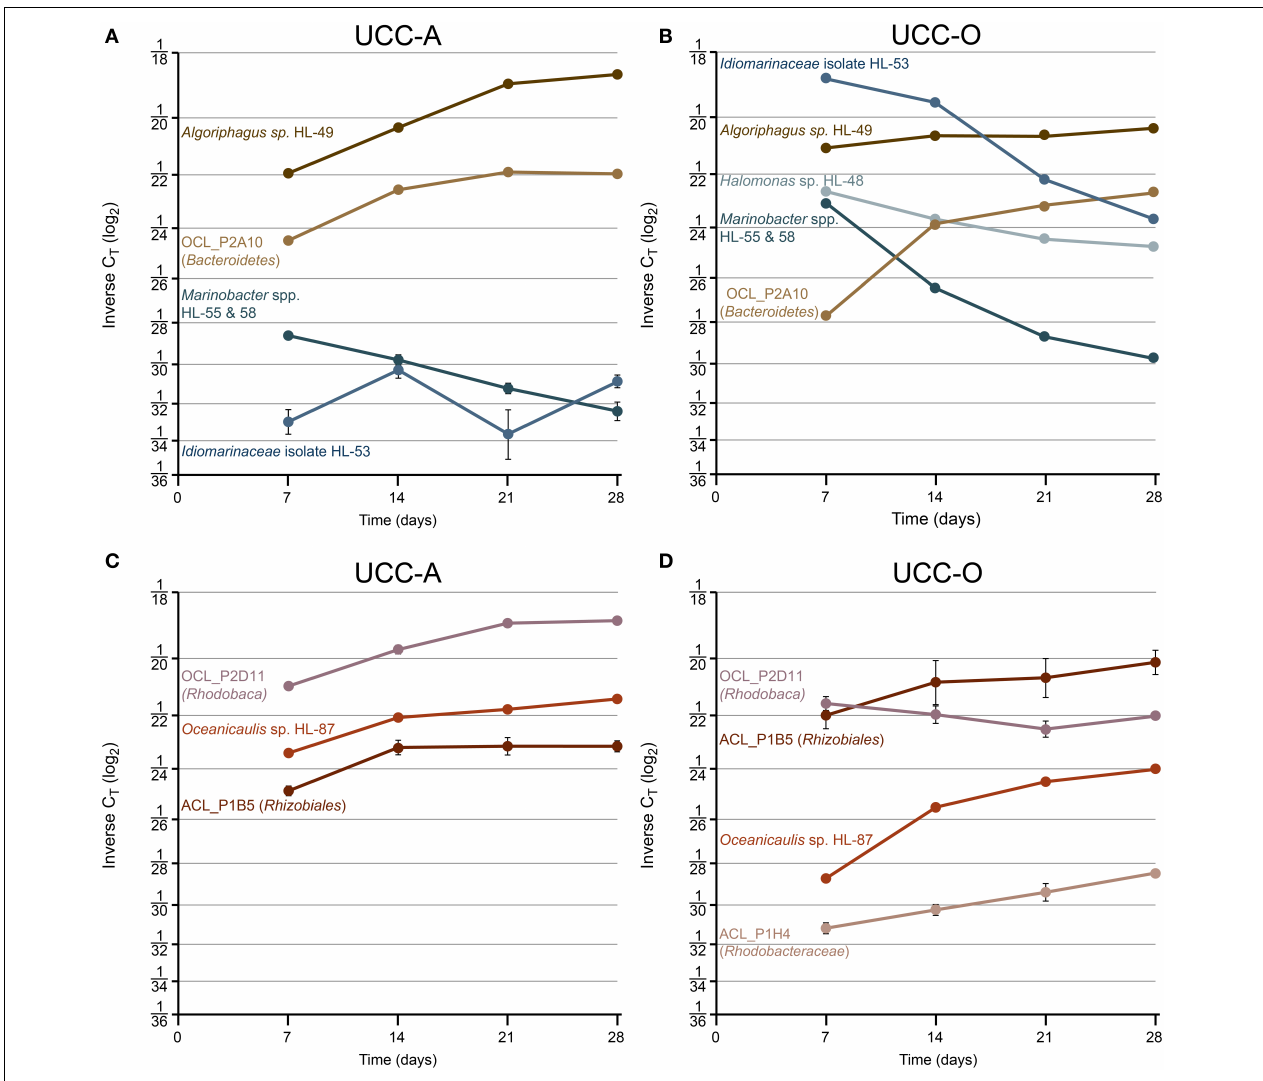
FIGURE 8 | Species-resolved dynamics in community structure within the assembling consortial biofilms. Relative abundances of individual species quantified by real-time PCR at days 7, 14, 21, and 28. Variation in relative abundance of members of Gammaproteobacteria (shades of blue) and Bacteroidetes (shades of brown) (UCC-A, A ; UCC-O, B ) and Alphaproteobacteria (shades of red) (UCC-A, C ; UCC-O, D ) are depicted